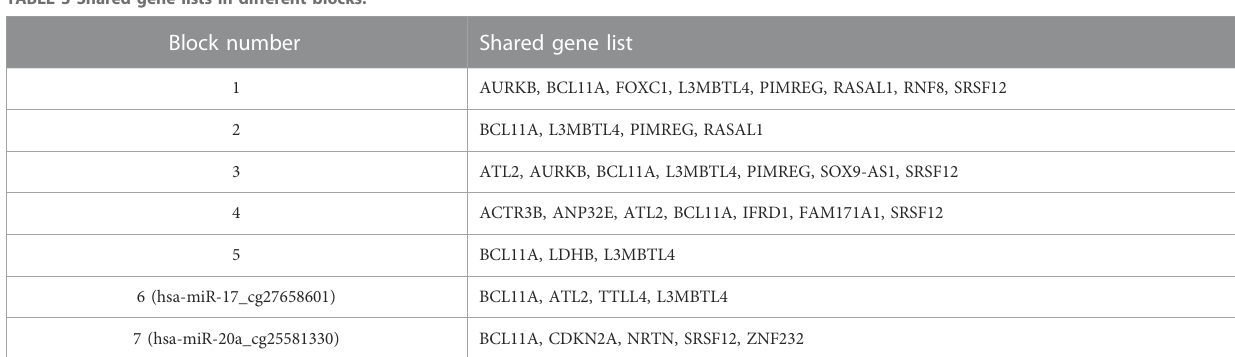
TABLE 3 Shared gene lists in different